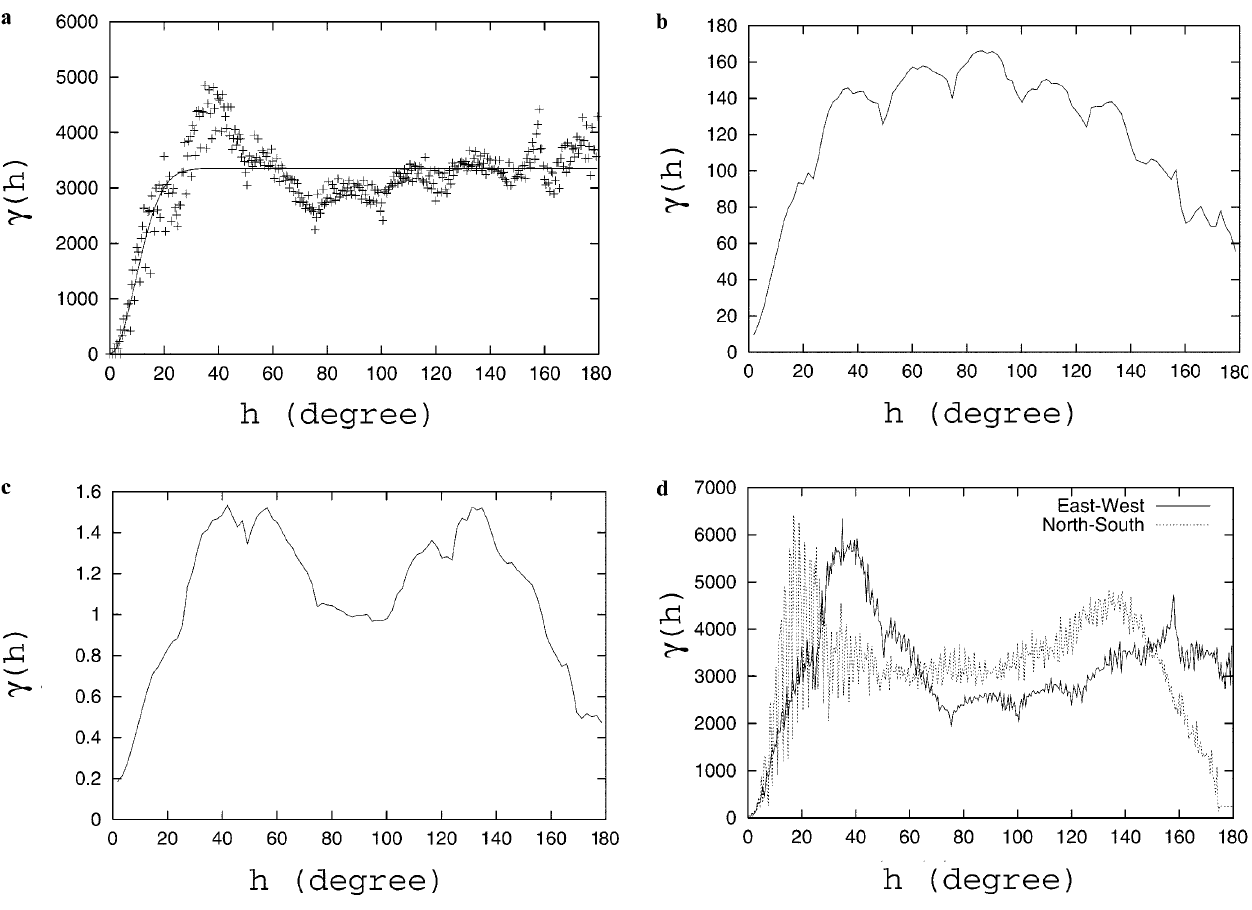
Fig. 3. a Isotropic semi-variogram calculated from the total ozone field provided by the SBUV dataset and fitted with the gaussian model ( solid line ) ( C 0 (cid:136) 0, C 1 (cid:136) 3350 and R (cid:136) 13), October 5, 1988. b Isotropic semi-variogram calculated from ozone concentration of layer 5 provided by the SBUV dataset, October 5, 1988. c Isotropic